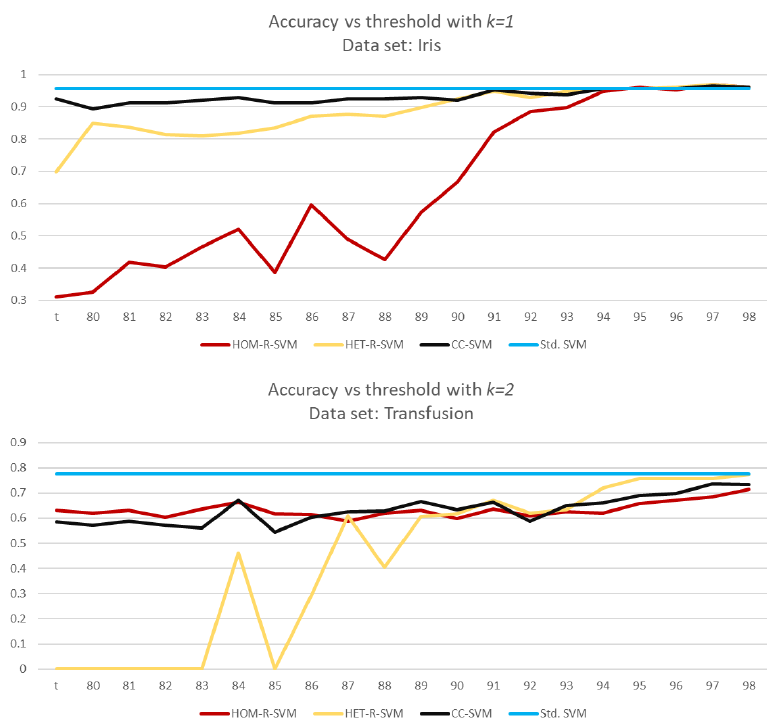
Figure 10. Analysis for accuracy values of Iris and Transfusion data sets.